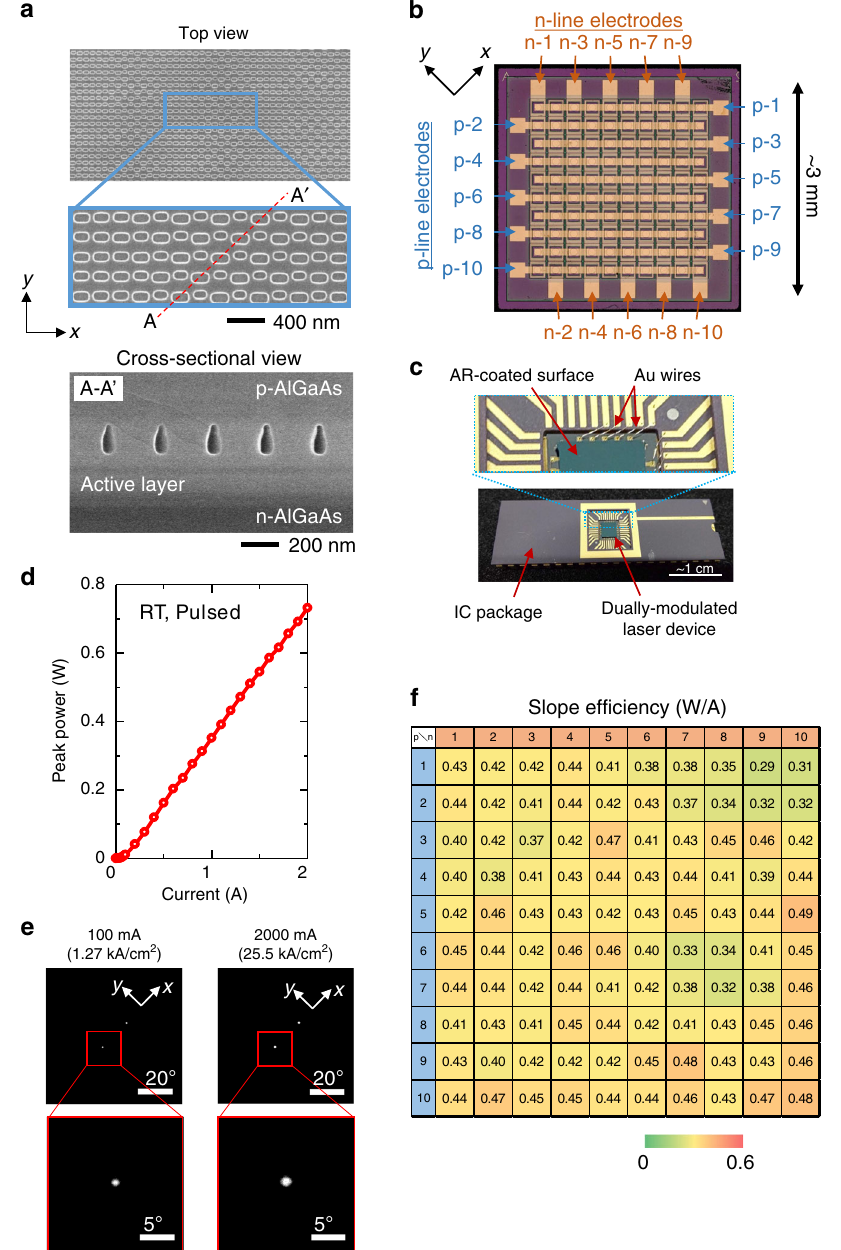
Fig. 5 Fabrication and characterization of the on-chip dually modulated photonic-crystal laser array. a Top and cross-sectional SEM images of a dually modulated photonic crystal before and after air-hole-retained regrowth by MOVPE, respectively. The photonic crystal is fabricated for emission at θ ¼ 10 (cid:4) and ϕ ¼ 0 (cid:4) = 180 (cid:4) . b Optical microscope image of the back side of the fabricated device, with electrodes clearly visible. c Device after having been fl ip-chip bonded to an IC package. Laser light emitted from the AR-coated surface of the SI-GaAs substrate. d Current light-output characteristics measured by driving electrodes n-1 and p-4 under pulsed conditions (100 ns, 1 kHz) at room temperature (RT). e Far- fi eld patterns for emission at θ ¼ 10 (cid:4) and ϕ ¼ 0 (cid:4) = 180 (cid:4) at different injected currents. f Measured slope ef fi ciency of all 100 integrated